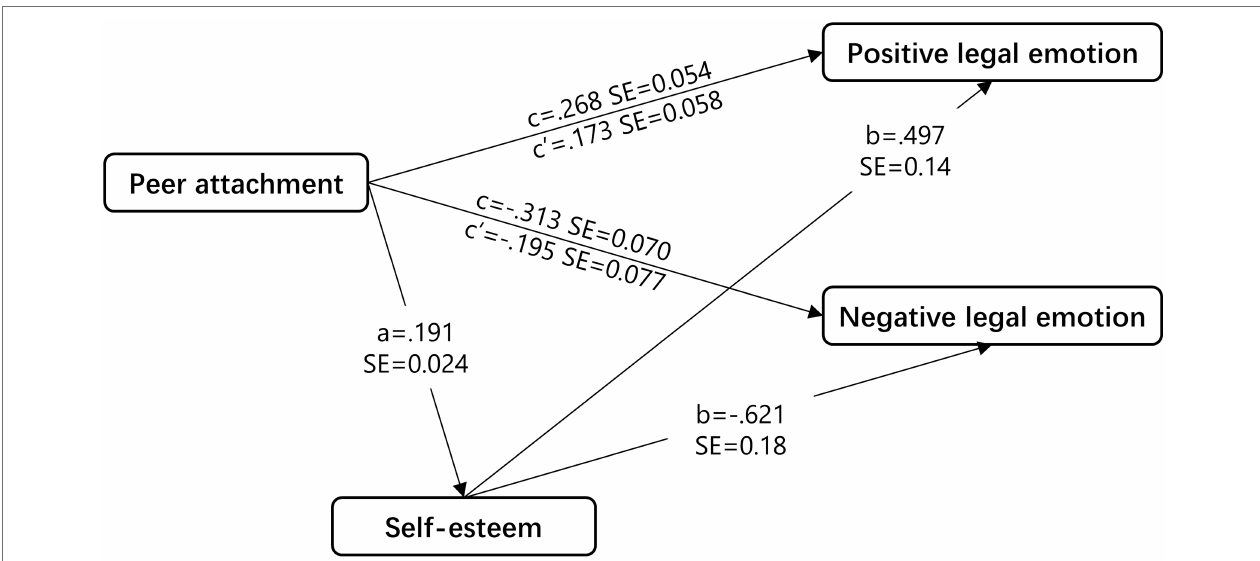
FIGURE 1 | Hypothesized model with self-esteem as the mediator between peer attachment and legal emotion for the entire sample. Unstandardized regression weights are presented. Controlled variables (age and gender) are omitted for clarity. All paths were significant at the p < 0.01 level.